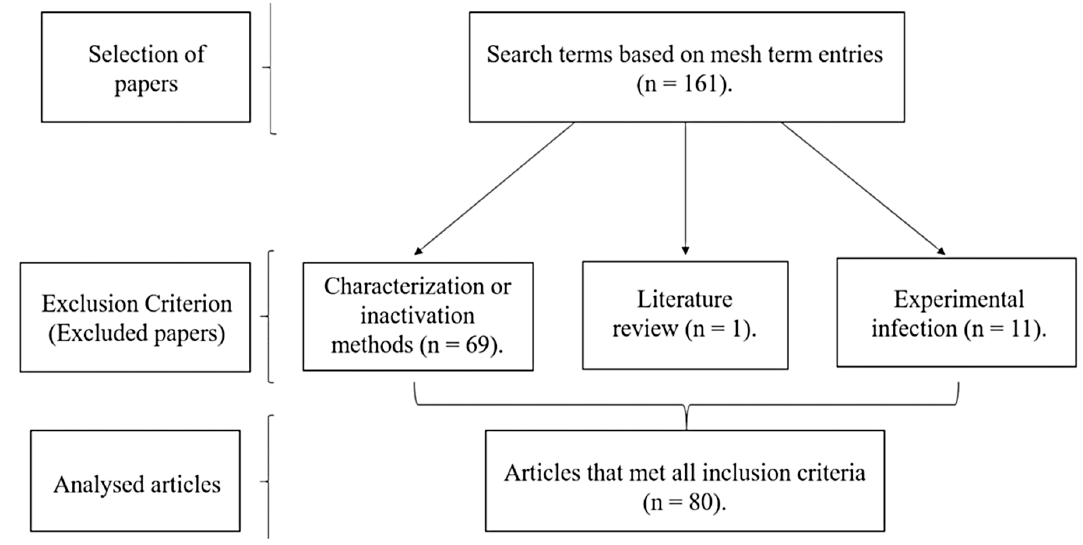
Figure 1. Papers selection and exclusion scheme.